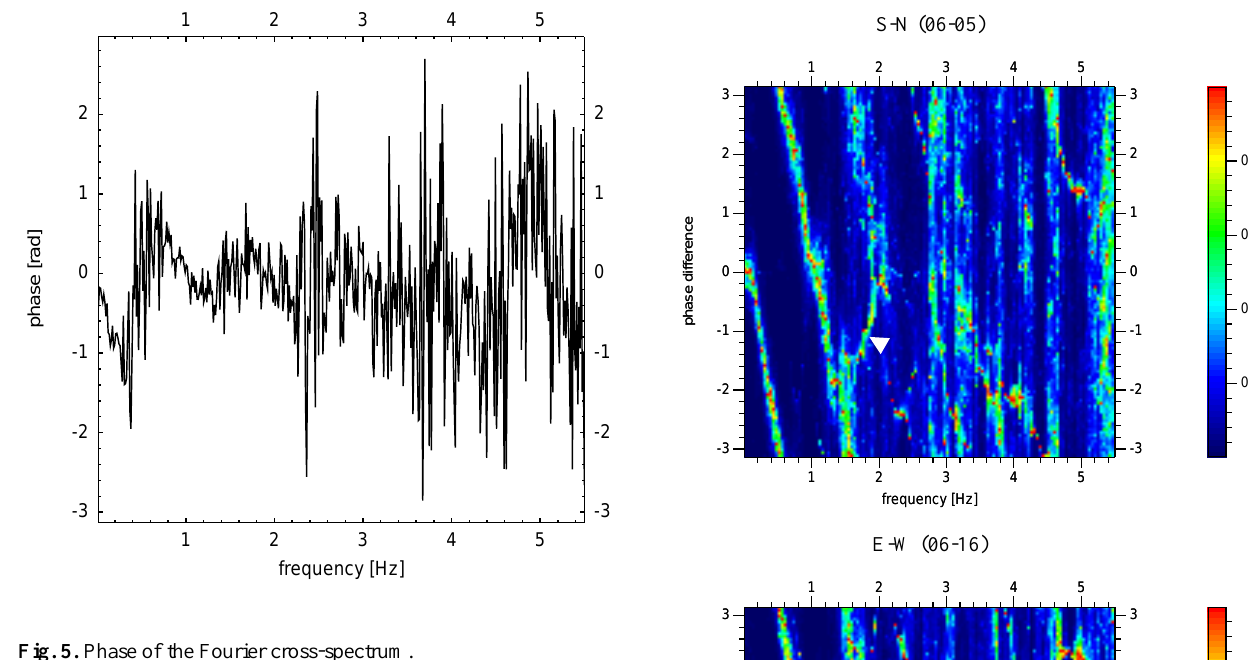
Fig. 5. Phase of the Fourier cross-spectrum.